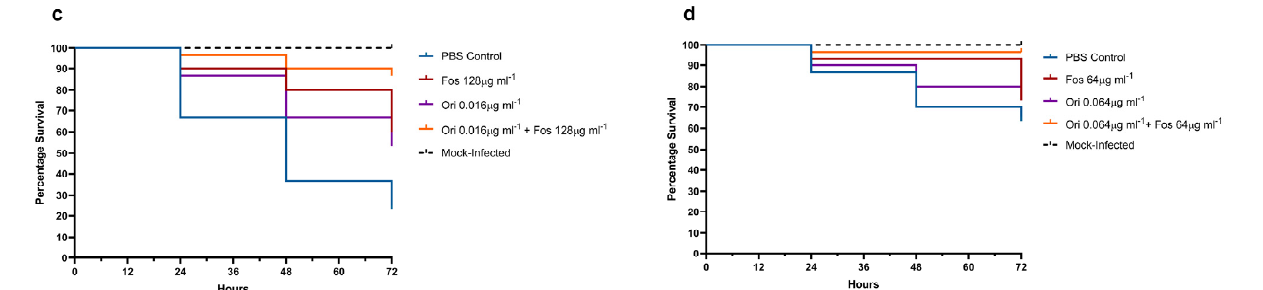
Figure 3. Survival rates for Galleria mellonella larvae treated with fosfomycin (Fos), oritavancin (Ori), or a combination of both antimicrobial agents. Larvae were infected with ( a ) Ef-3, ( b ) Ef-4, ( c ) EF-8, ( d ) Ef-10. Mock-infected controls refer to larvae that received a PBS injection in place of a bacterial strain. PBS controls refer to larvae that received bacterial inocula, but PBS in lieu of oritavancin, fosfomycin or combination treatment. Graphs show pooled data from three independent replicates consisting of 10 larvae.